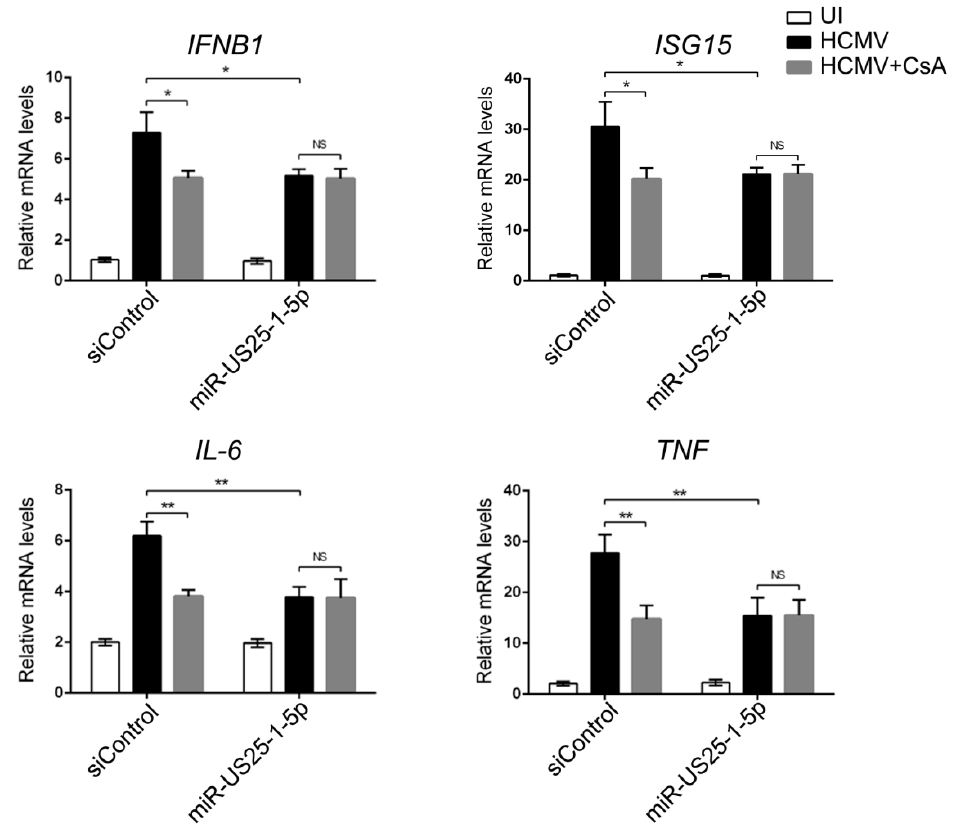
Figure 4. miR-US25-1-5p inhibits CD147-mediated early innate immune response to HCMV. Quantitative RT-PCR analysis of IFNB1 , ISG15 , IL-6 , and TNF mRNA in siControl or miR-US25-1-5p stable HFF cells with HCMV uninfected (UI) or infected (MOI = 0.5) for 6 h and CsA present (HCMV + CsA) or absent in the culture medium. The graphical data are presented as the means ± the SDs ( n = 3); NS denotes not significant ( p > 0.05); * denotes p < 0.05, ** denotes p < 0.01.